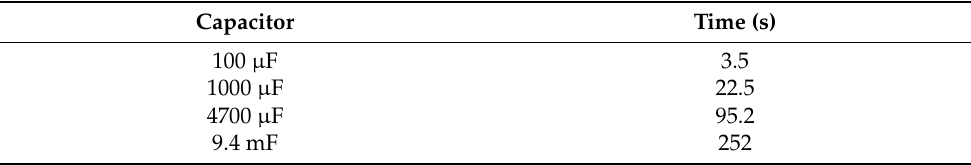
Table 1. Charging time of the capacitors.